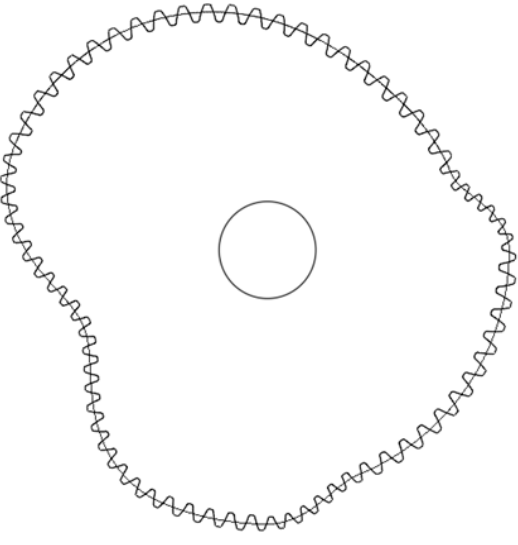
Figure 8. The shape of the final designed driving gear.